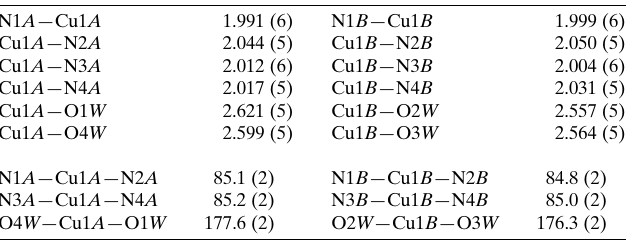
Table 1 Selected geometric parameters (A˚ , (cid:4) ).